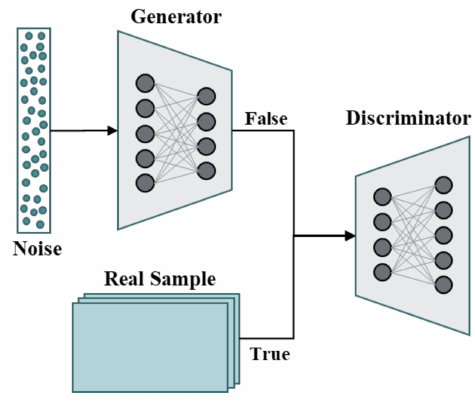
Figure 1. The structure of the GAN